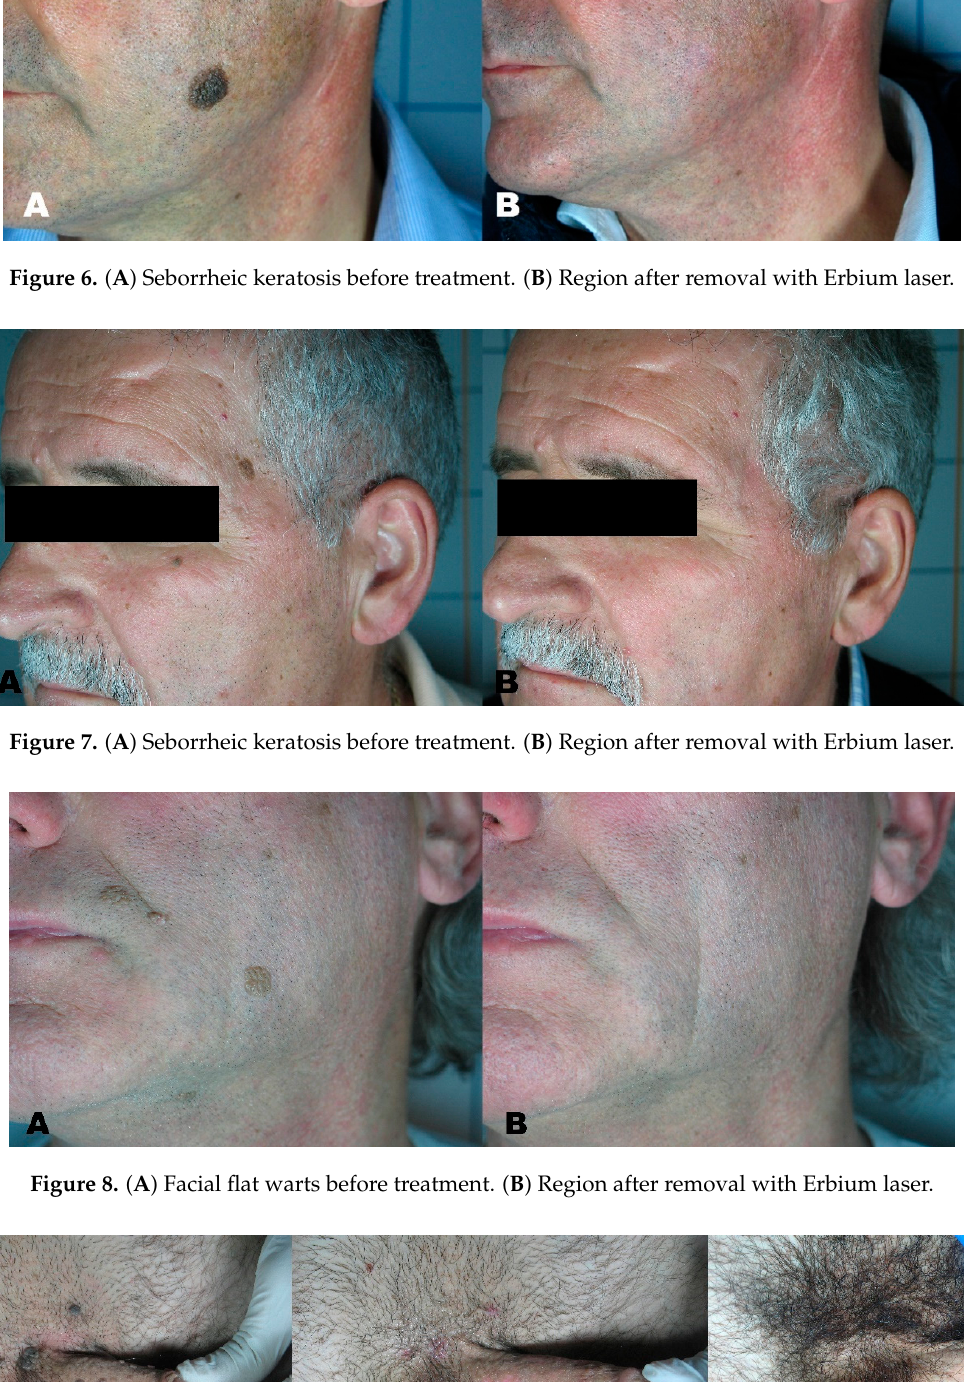
Figure 5. ( A ) Ear wart before treatment, ( B ) Region after removal with Erbium laser.